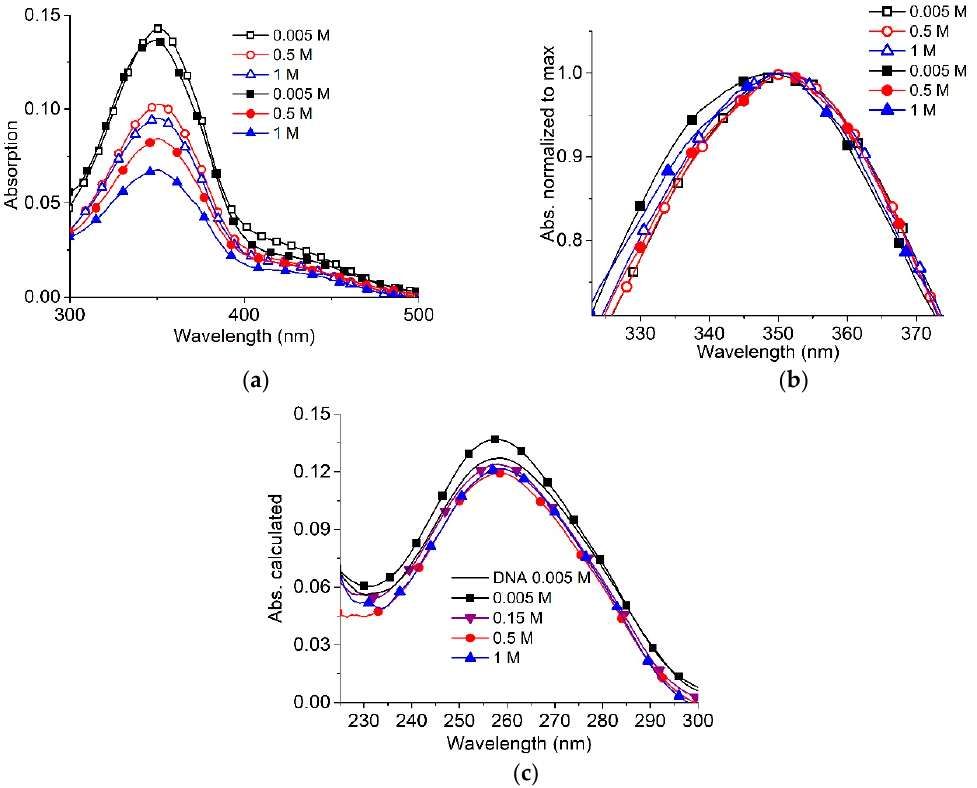
Figure 5. Surfactant absorbance spectra in solutions with DNA at z = 0.5 (filled signs) and without DNA (open signs) at varied [NaCl] (as depicted) ( a ); normalized surfactant absorbance band ( b ); calculated DNA absorbance in complexes (filled signs) and spectrum of free DNA (solid line) ( c ). [AzoTAB] = 2 × 10 − 6 M; [DNA] = 4 × 10 − 6 M (P).